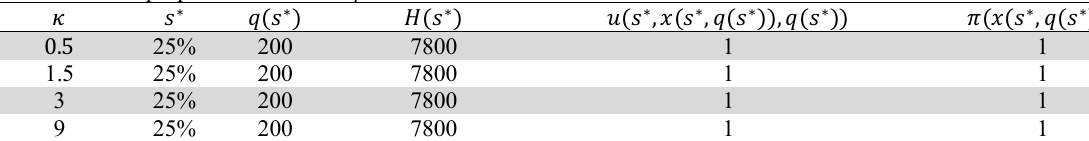
Solutions of the proposed model with 𝜑 = 0.5